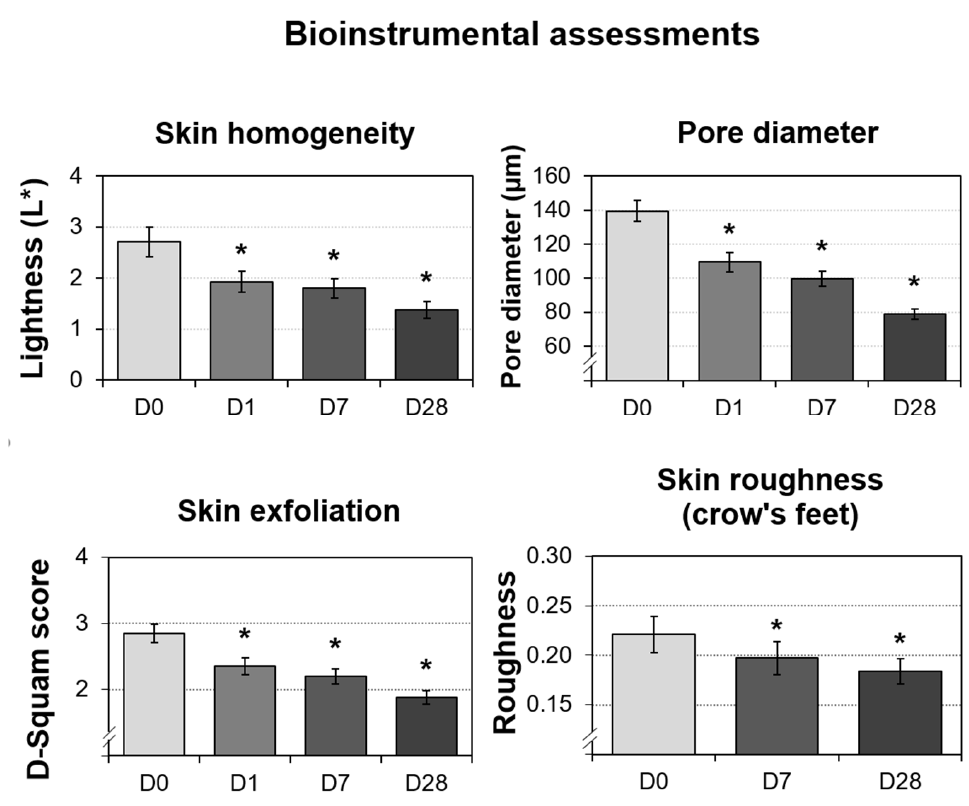
Figure 8. Bioinstrumental measurements performed on 30 Caucasian subjects after nightly use of the cream (test product) during 28 days. The data presented are the mean ± SD at D0 (baseline), D1, D7, and D28. Statistical comparisons of the mean values to D0 were achieved by Student’s t- or Wilcoxon tests depending on the normality of the distribution (* p < 0.05).